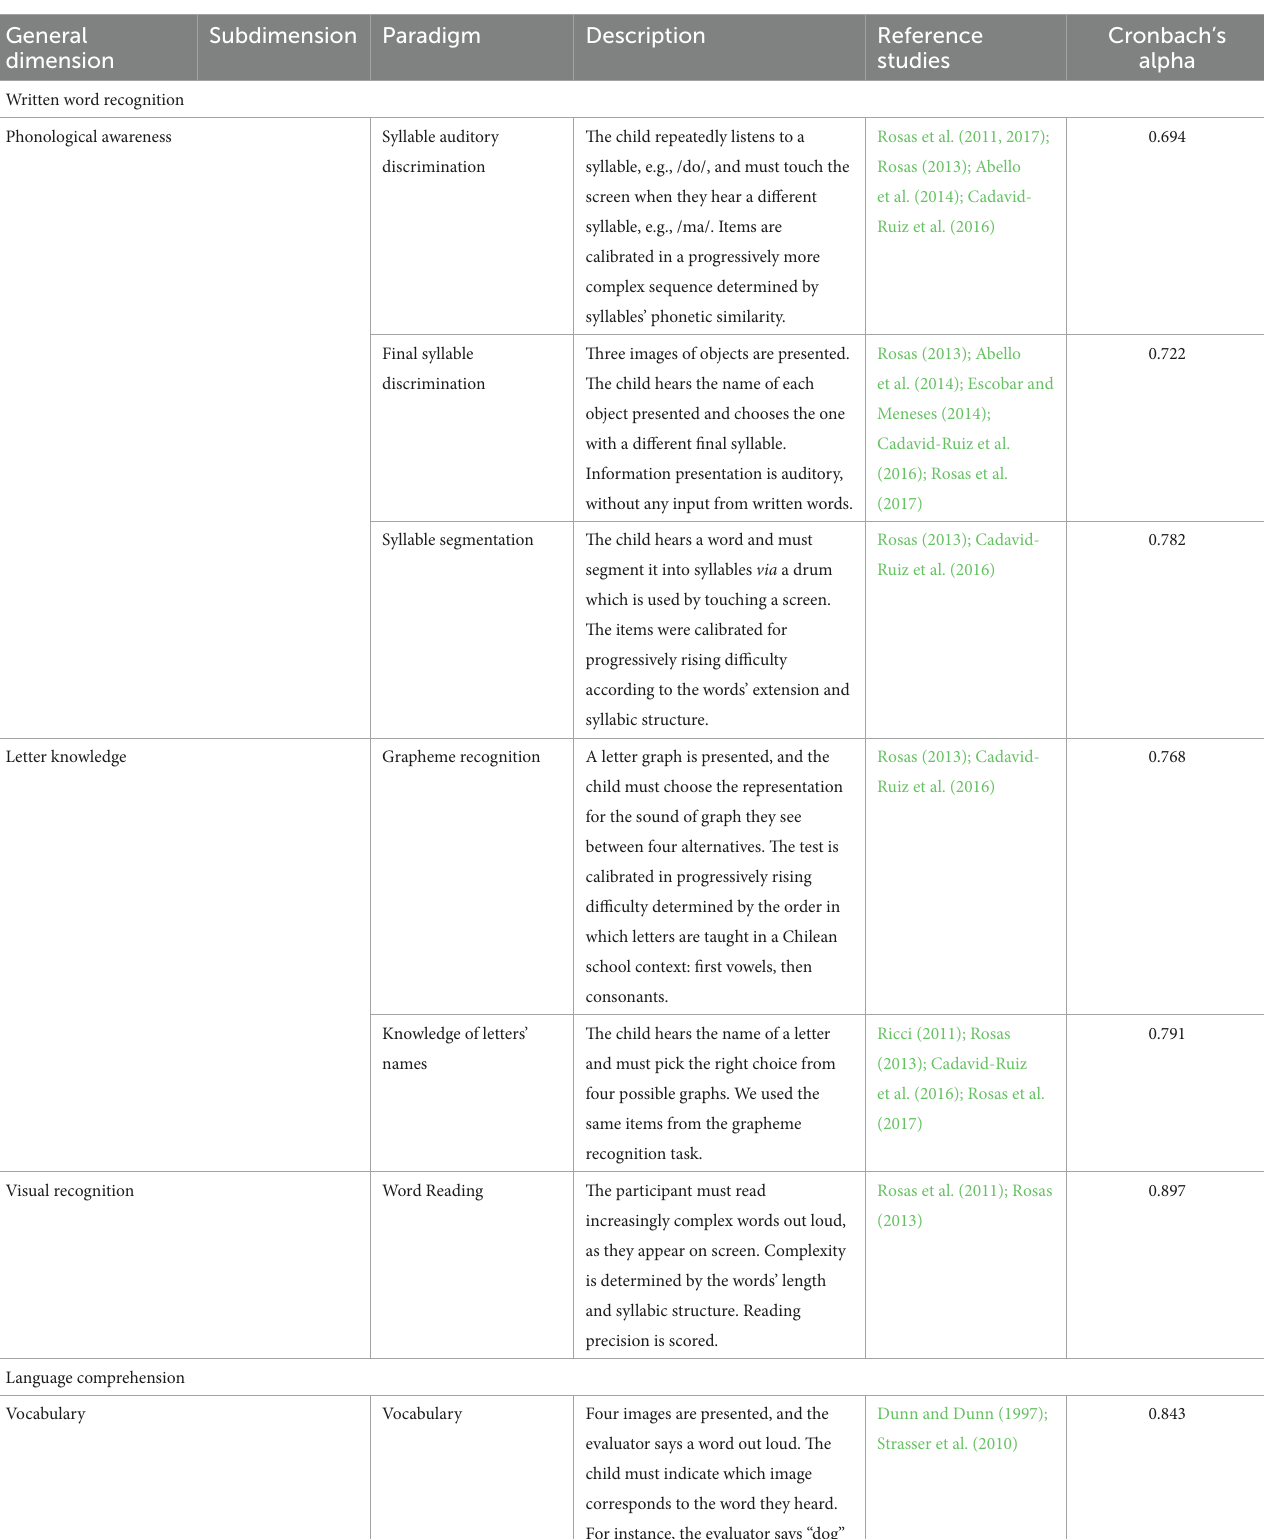
TABLE 1 Description of experimental